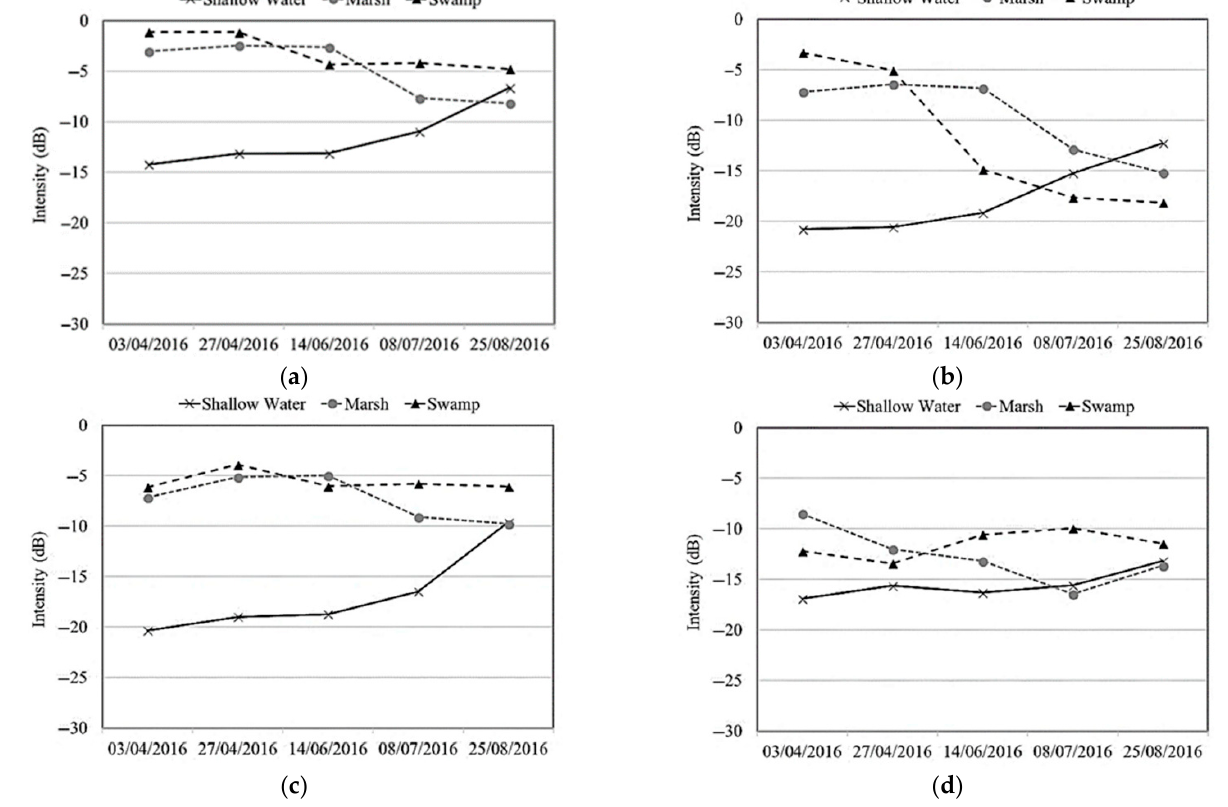
Figure 14. Change in the mean values of ( a ) total power, ( b ) double-bounce backscatter, ( c ) volume backscatter, and ( d ) surface scattering over time for the 1000 randomly selected samples in the FP radar data. All values are represented in intensity (dB).